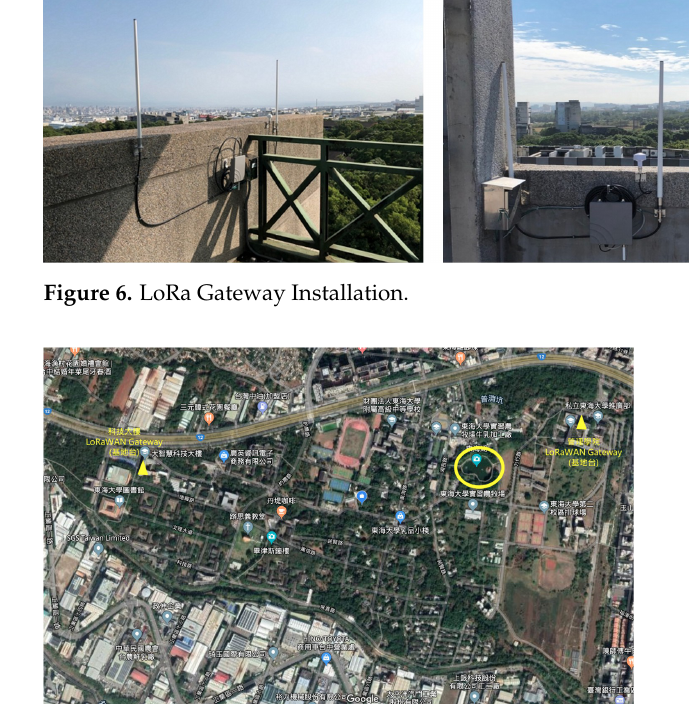
Figure 7. LoRa Campus Test